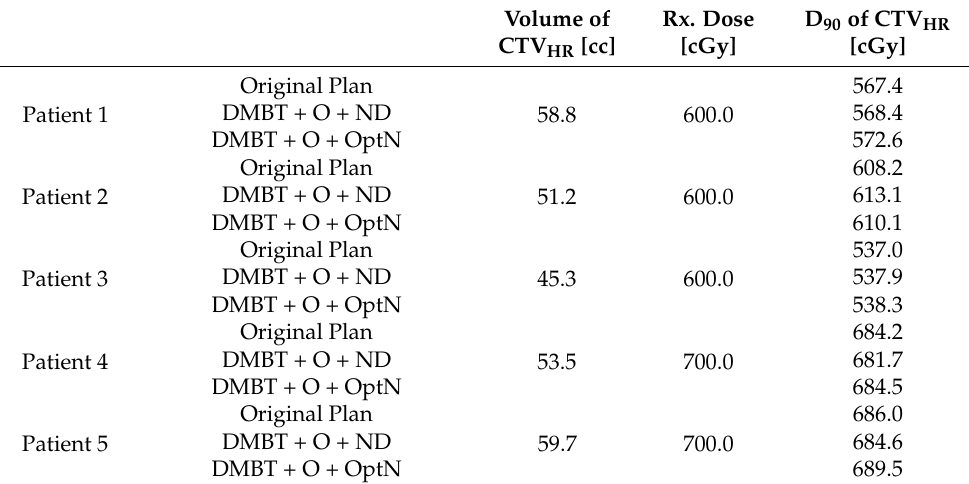
Table 1. The prescription dose, CTV HR volume, and D 90 values between the original, DMBT + O + ND, and DMBT + O + OptN